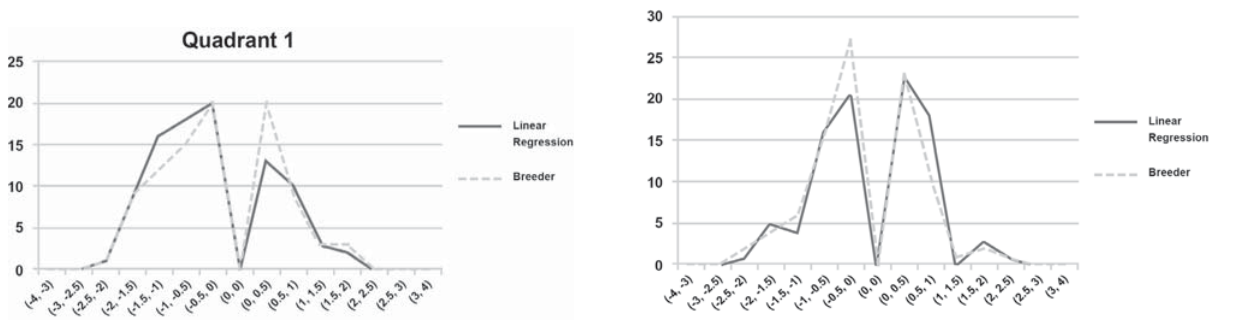
Figure 6- The comparison of prediction error in quadrant 4